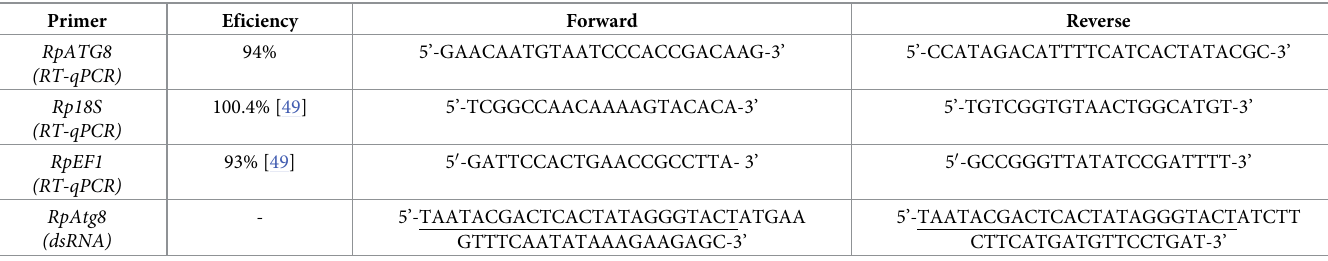
Table 1. Primers